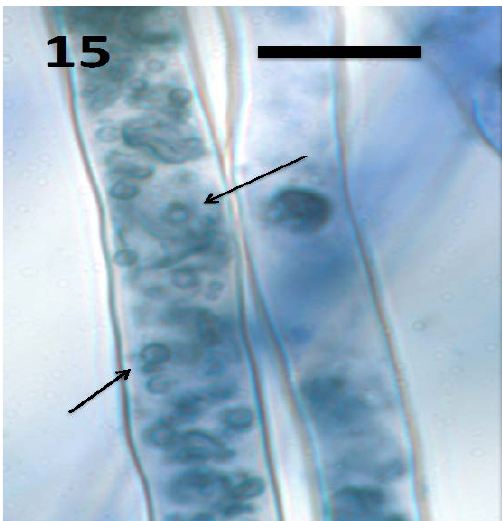
Figure 15. Root hairs of Froelichia gracilis seedling showing internal wall-less cells (mycosomes) of fungus Aureobasidium pullulans (arrows; bar = 15 µm; stained with 3,3-diaminobenzidine followed by aniline blue).